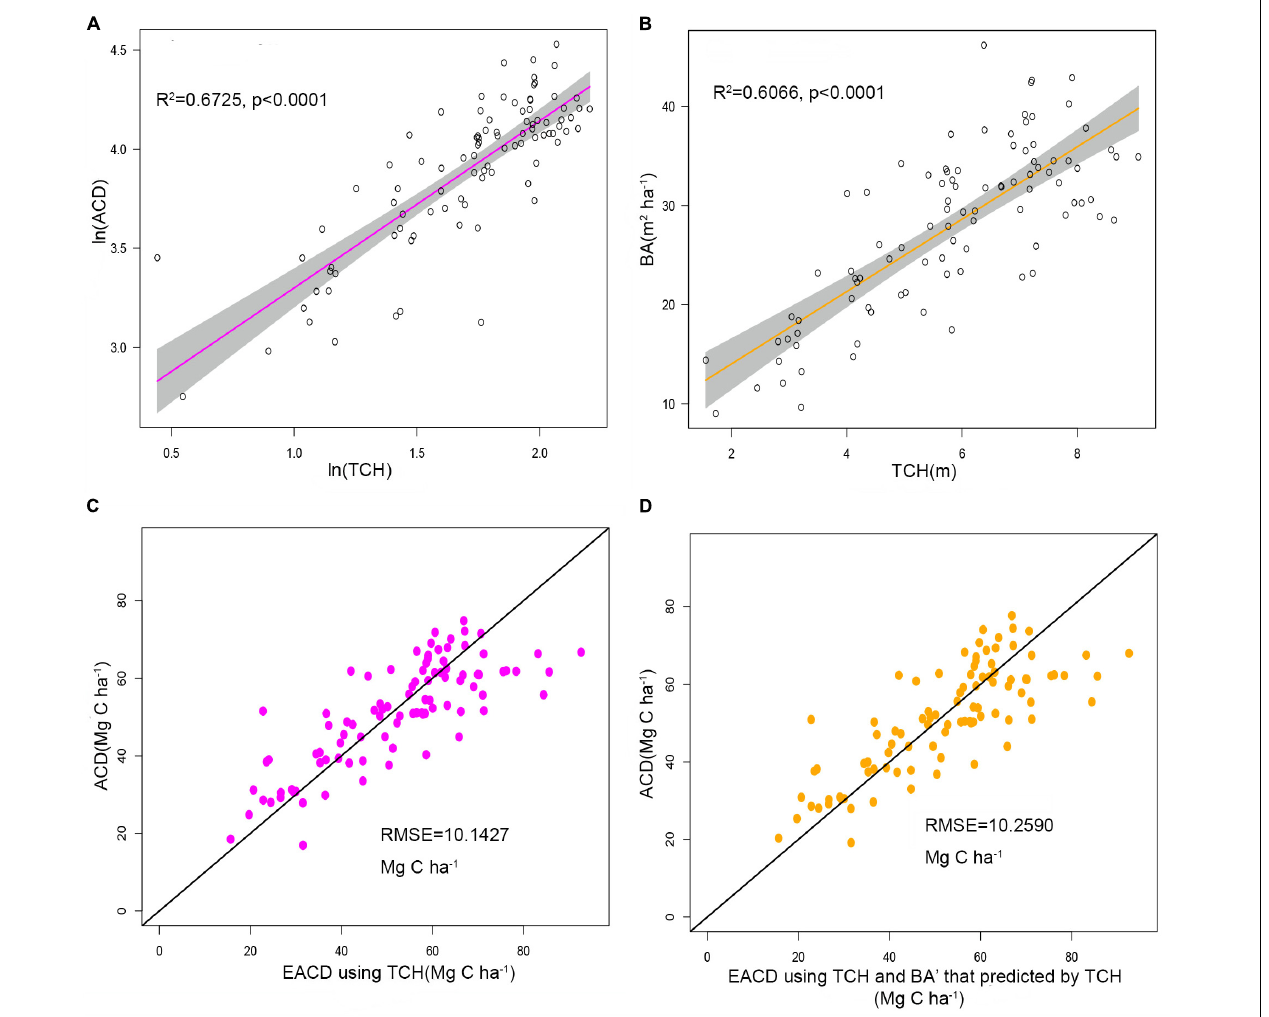
FIGURE 4 | (A) Linear relationship between ln(TCH) and ln(ACD). (B) Linear relationship between TCH and the basal area (BA). The shadowed region shows the 95% confidence interval. (C) ACD estimated using top of canopy height (TCH) from LiDAR compared to field-surveyed ACD. (D) ACD estimated using TCH and BA